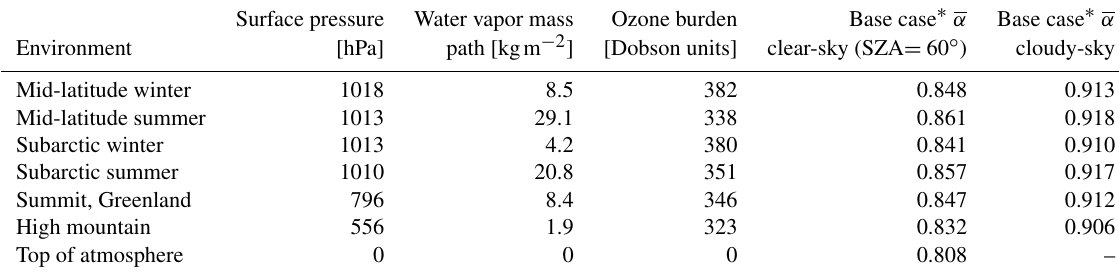
Table 1. Atmospheric profile